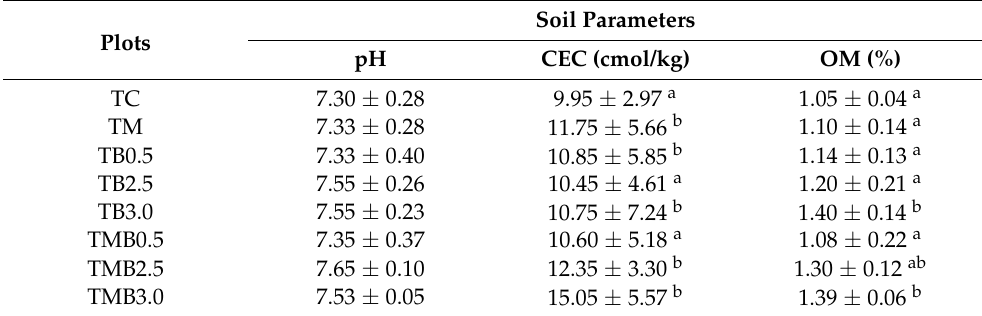
Table 5. The characteristic of soil in different experimental plots after maize cultivation.